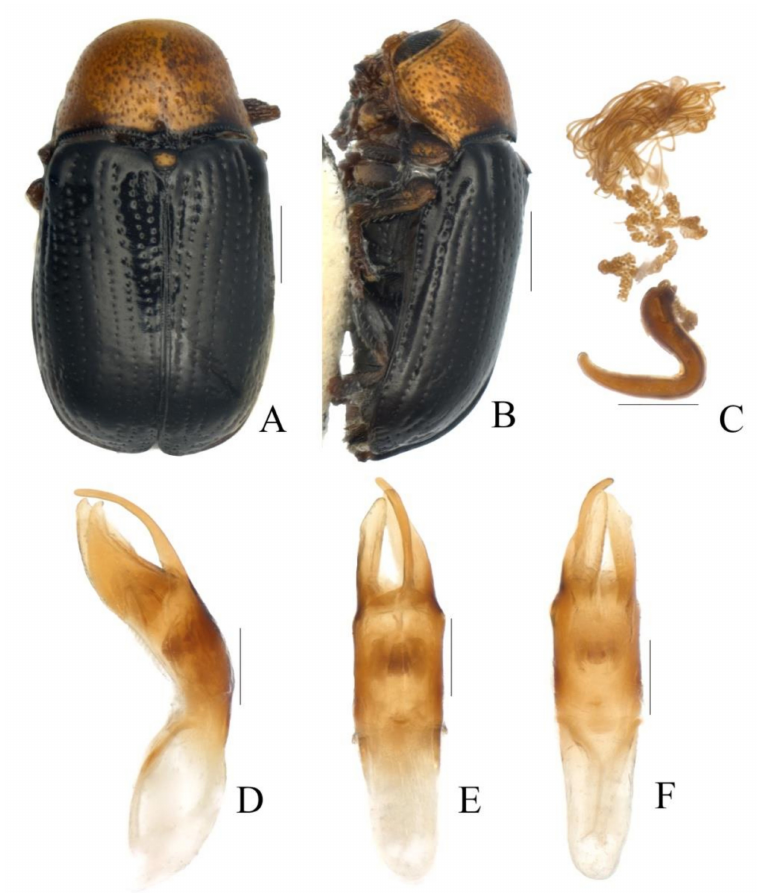
Figure 26. Cryptocephalus ( Burlinius ) petulans Weise, 1889: ( A ) habitus; ( B ) lateral view of habitus; ( C ) spermatheca; ( D ) lateral view of aedeagus; ( E ) dorsal view of aedeagus; ( F ) ventral view of aedeagus (Scale bars: ( A , B ) = 0.5 mm, ( C – F ) = 0.2 mm) (( A , B , D – F ): male; ( C ): female; both from